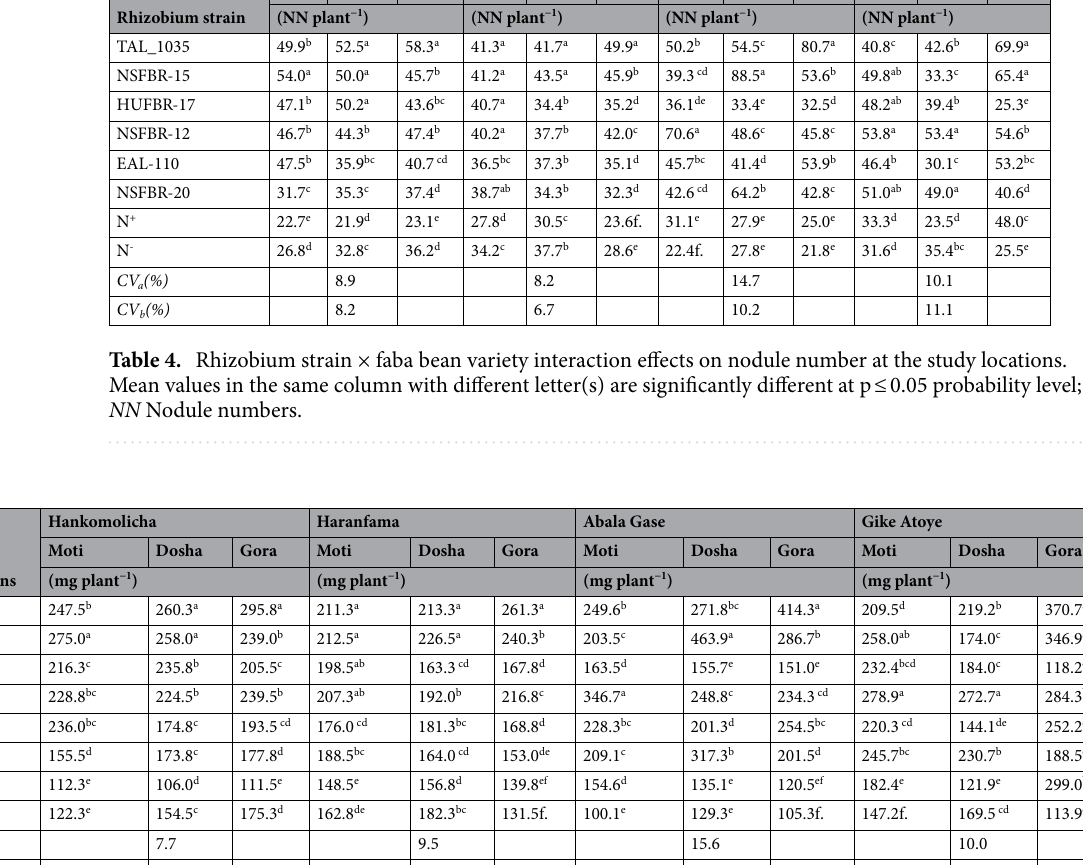
Table 5. Rhizobium strain × faba bean variety interaction effects on nodule dry weight at the study locations. Mean values in the same column with different letter(s) are significantly different at p ≤ 0.05 probability level.